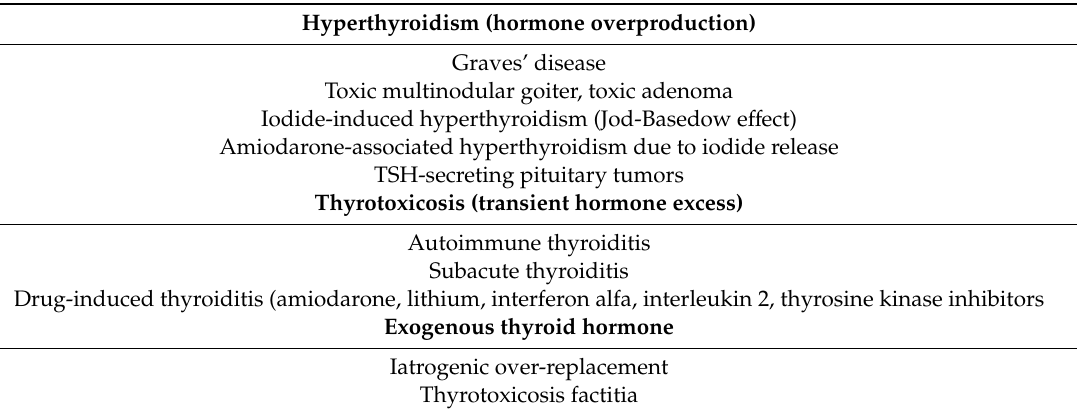
Table 1. Causes of